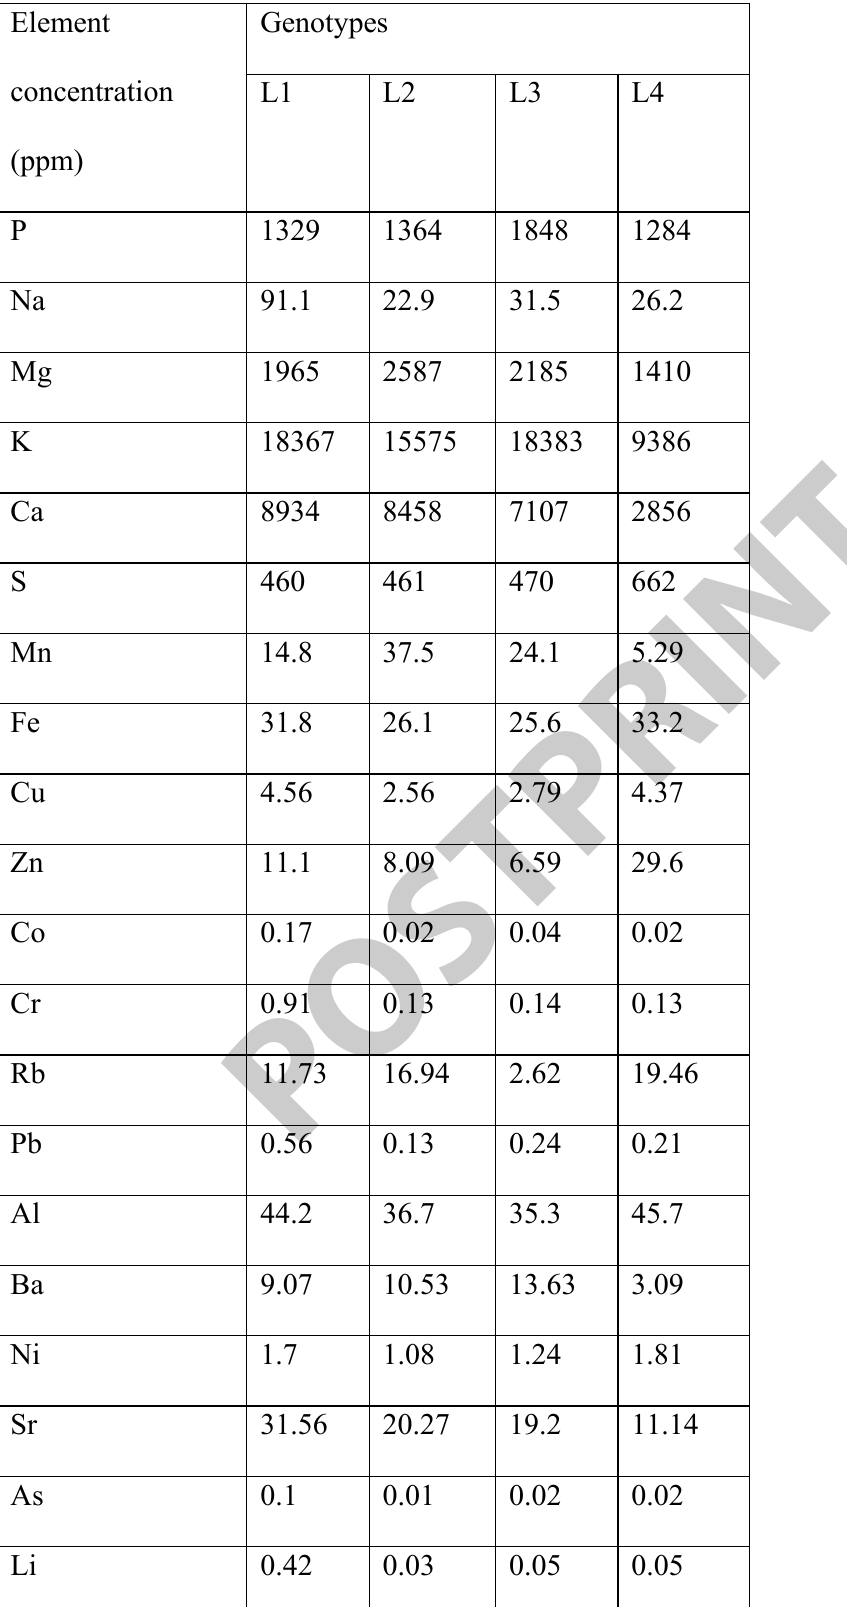
Table 3. Concentrations of macro and micro elements in rosehip fruits genotypes